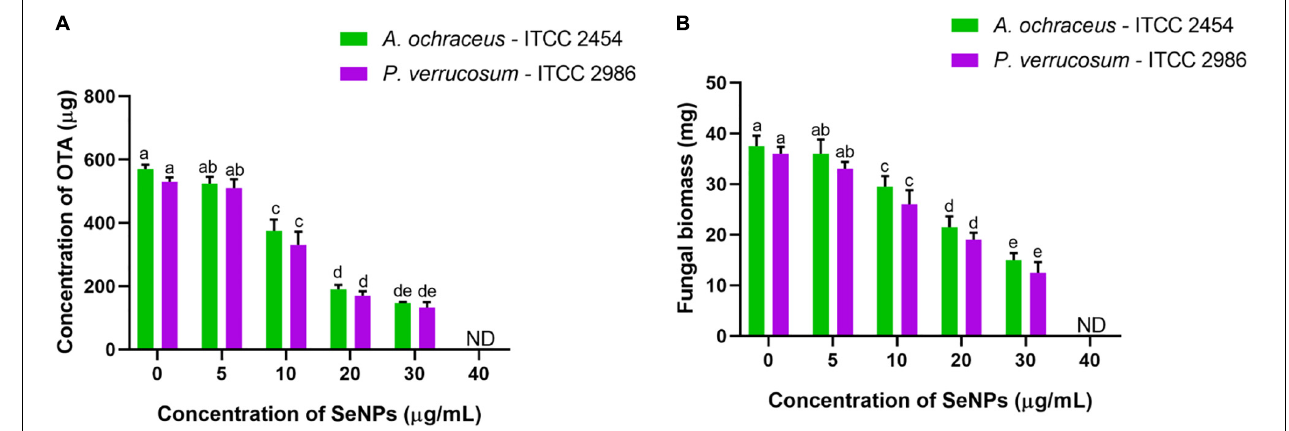
FIGURE 9 | Dose-dependent inhibitory activity of SeNPs on (A) ochratoxin A (B) fungal biomass of A. ochraceus and P. verrucosum . The experiments in the study were carried out three times, each time independently. The mean and SD of the triplicate research were calculated using the results from each experiment. The bar graphs with different letters within the particular analysis were significant ( p -value ≤ 0.05) by Tukey’s test. ND, not detected.